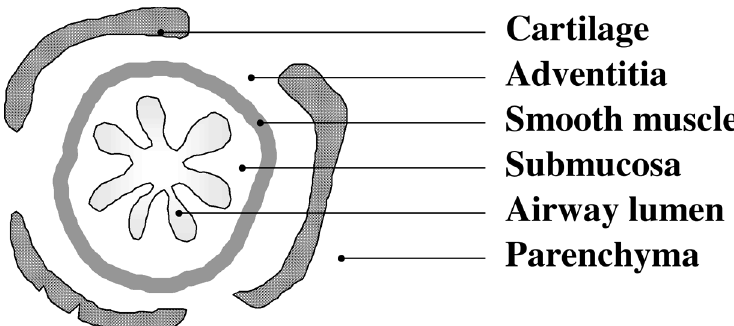
FIG. 1. Anatomical areas studied in counting cellular infiltrates. In the parenchyma, random fields were counted, well away from the airway. Adventitia, area between the smooth muscle layer and cartilage, or in the absence of cartilage, in a 50 m m layer adjacent to the outer edge of the smooth muscle; submucosa, area between the basement membrane and the inner perimeter of the smooth muscle